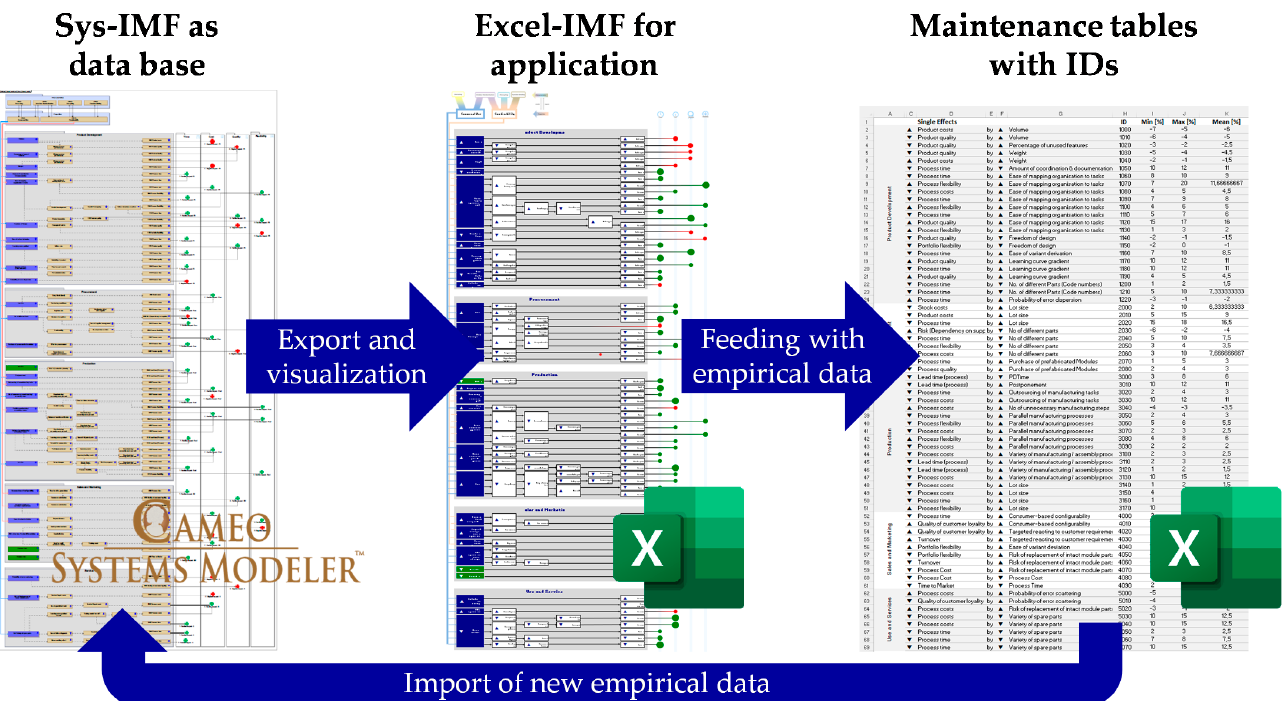
Figure 8. Data flow between Sys-IMF, Excel-IMF and maintenance tables for continuous and dy- namic data management.